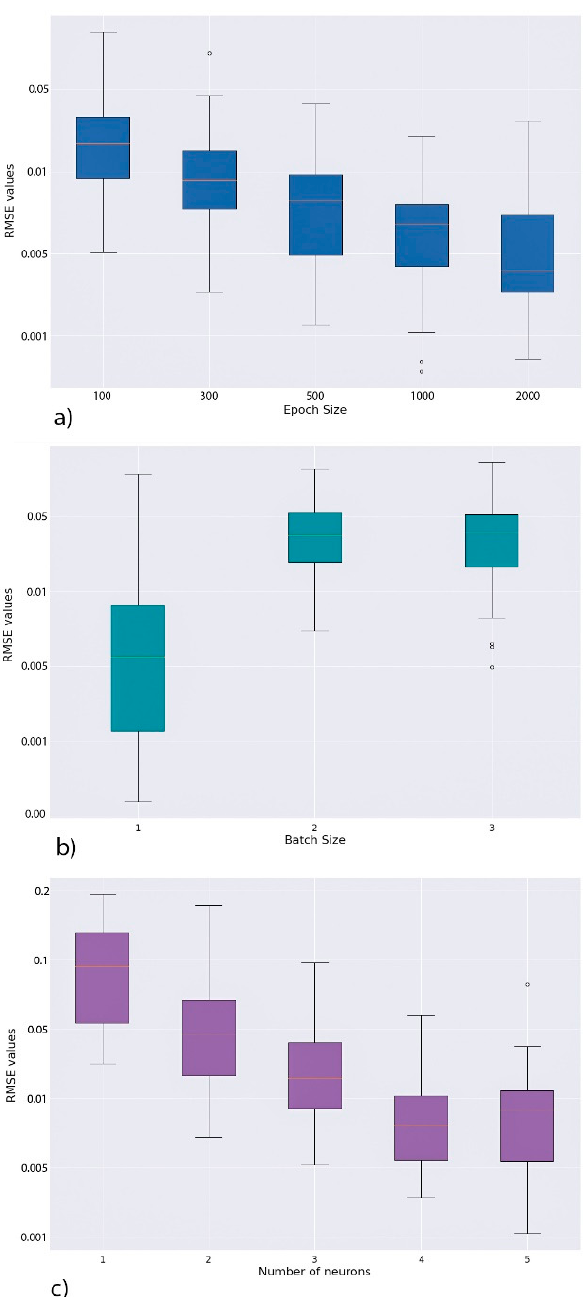
Figure 12. Change in the RMSE of the normalized values with the increase in the number of epoch size ( a ), batch size ( b ) and neurons ( c ).